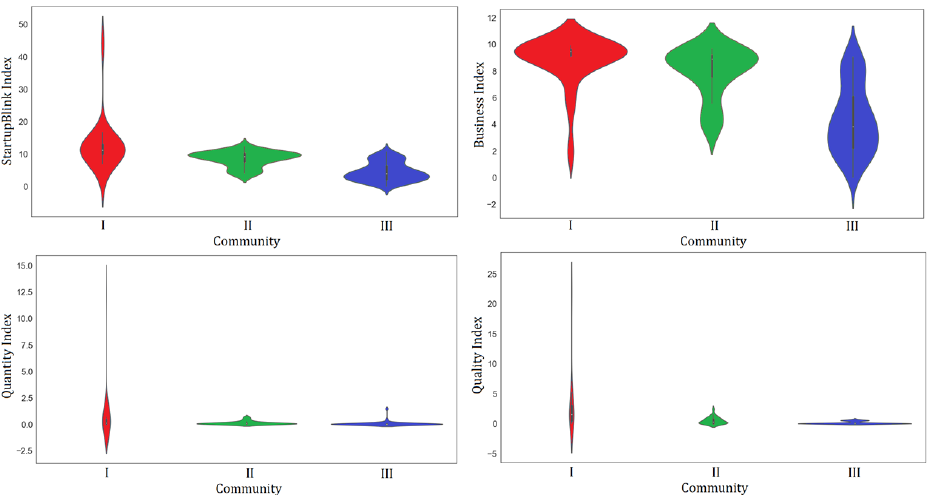
Figure 8. Violin plots of the distributions in the three wealth communities of the overall StartupBlink index ( top left panel), and of the specific business ( top right ), quantity ( bottom left ) and quality ( bottom right ) indexes. The plots related to the overall and the business index show a tendency of community distributions to separate from each other. This tendency, more pronounced in the overall case, is confirmed by the analysis of the resolution ratio.